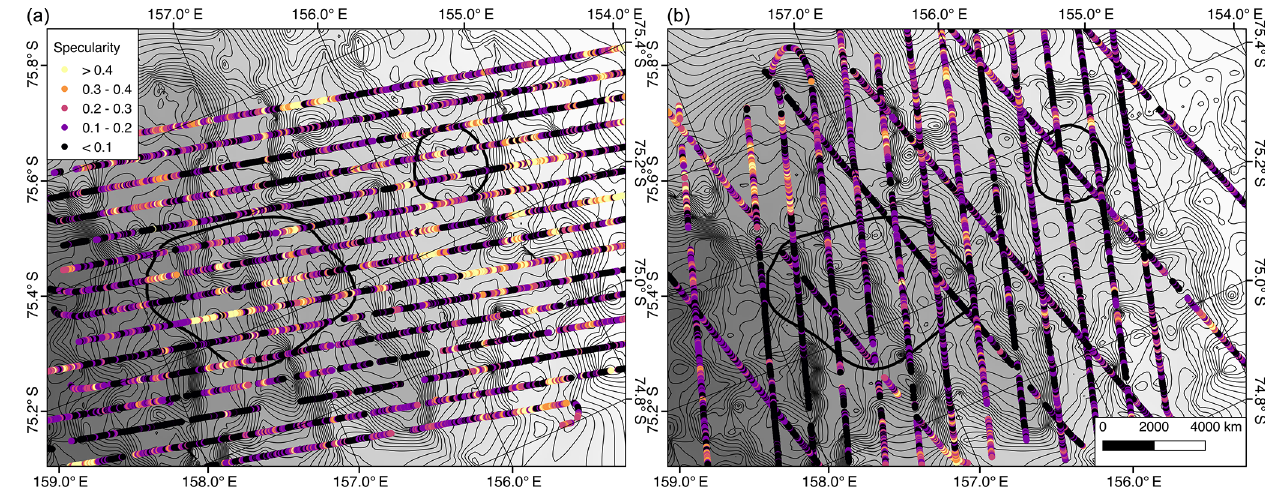
Figure 10. Specularity along- (a) and across-flow (b) of the main trunk. The background is the same as Fig. 9.